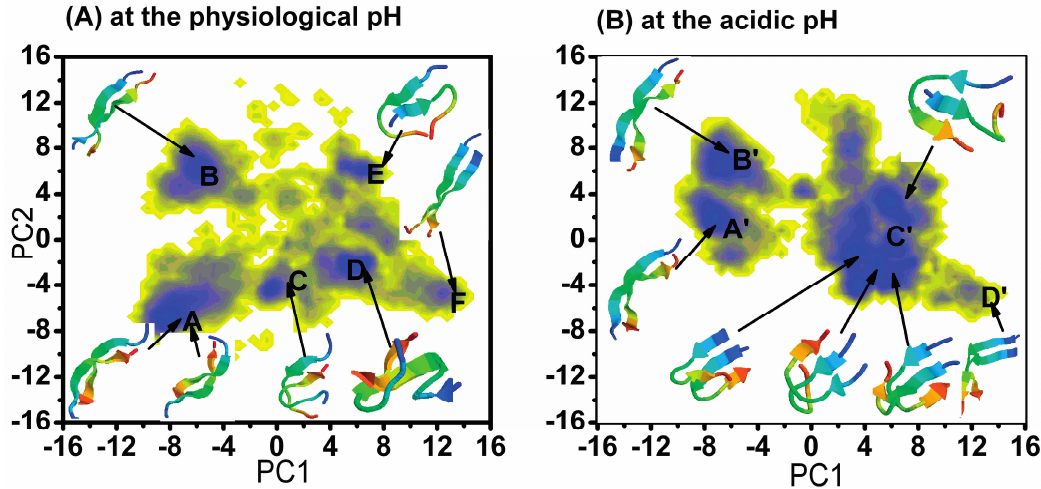
Figure 1. Free energy surface (in kJ/mol) of the ( α -syn12) 2 dimer ( A ) at the physiological pH and ( B ) at the acidic pH projected on the first two principal components PC1 and PC2 obtained from PCA of inter-chain side-chain inverse distances. The blue indicates the N-terminal. Table 1. The relative depths of the free energy minima of the α -syn12 dimer at the physiological pH. The Different Regions